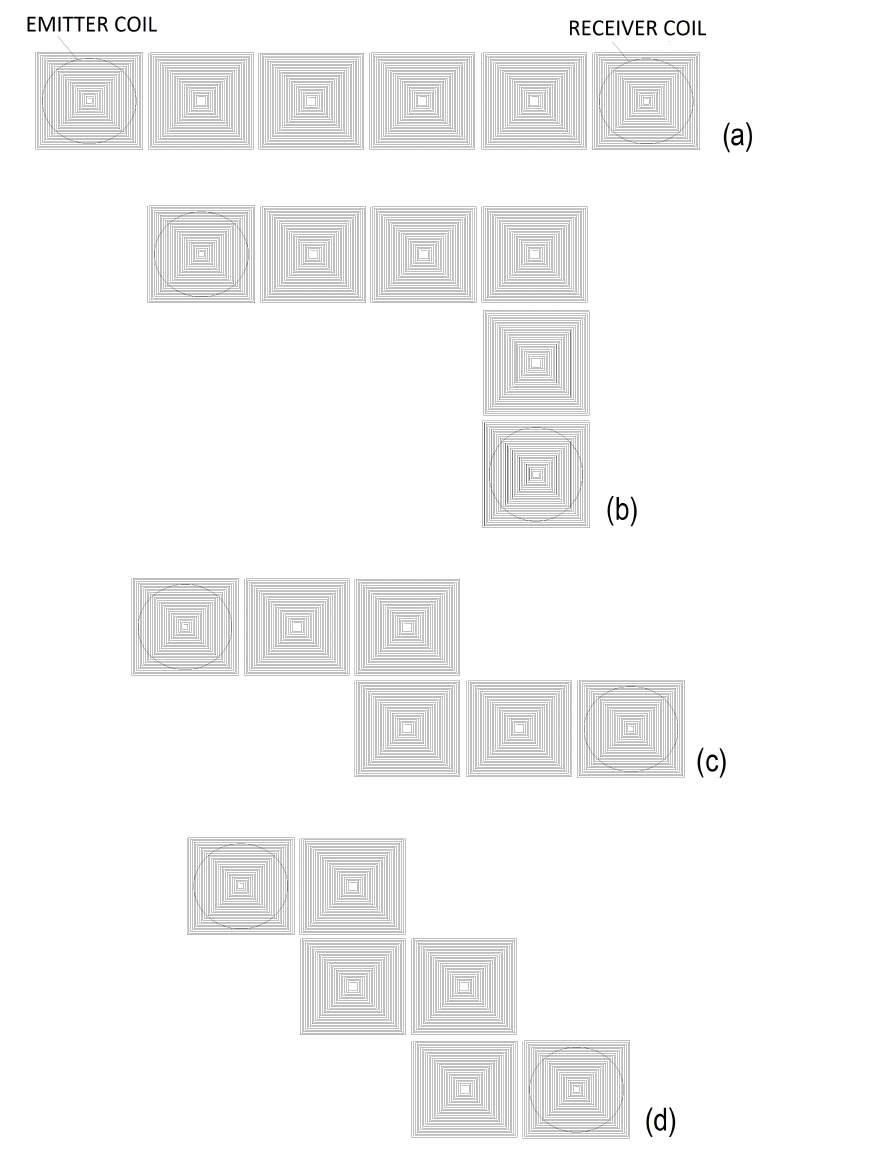
II-arrangement; ( c ) III-arrangement and ( d ) IV-arrangement. The receiver coil is